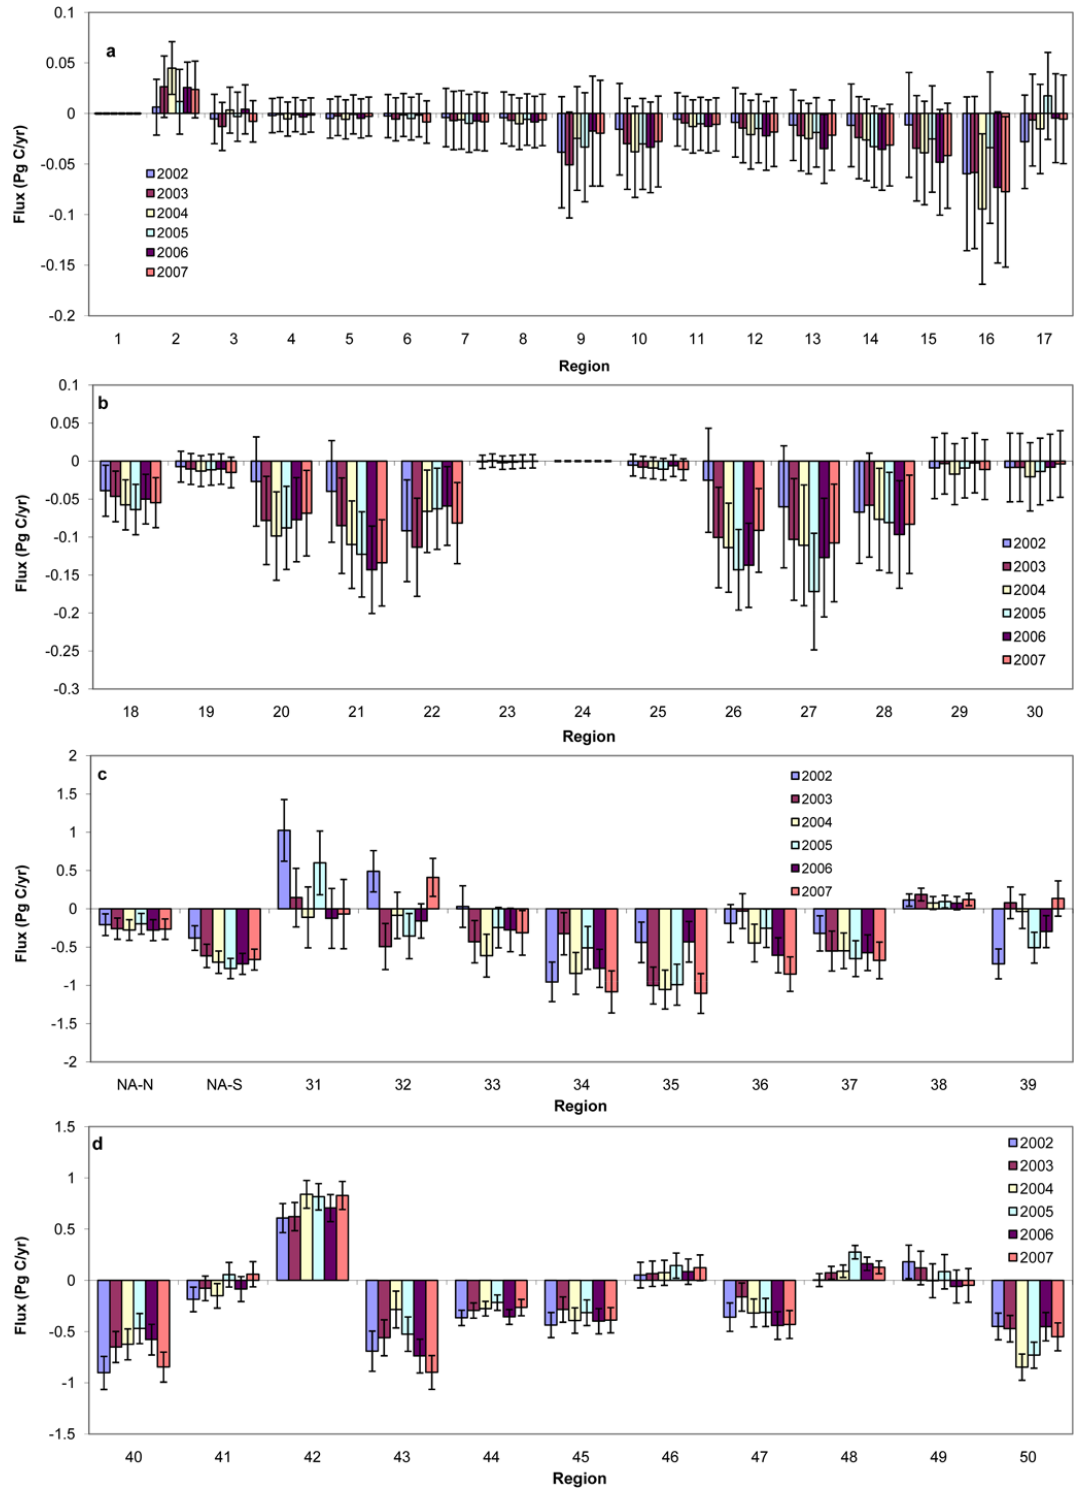
Fig. 4. Inverted CO 2 fluxes and their uncertainties for 2002 to 2007. (a) Northern North American small regions (1–17), (b) Southern North American small regions (18–30), (c) large land regions, including two aggregated North American regions: NA-N (Regions 1–17), and NA-S (Regions 18–30), and (d) ocean